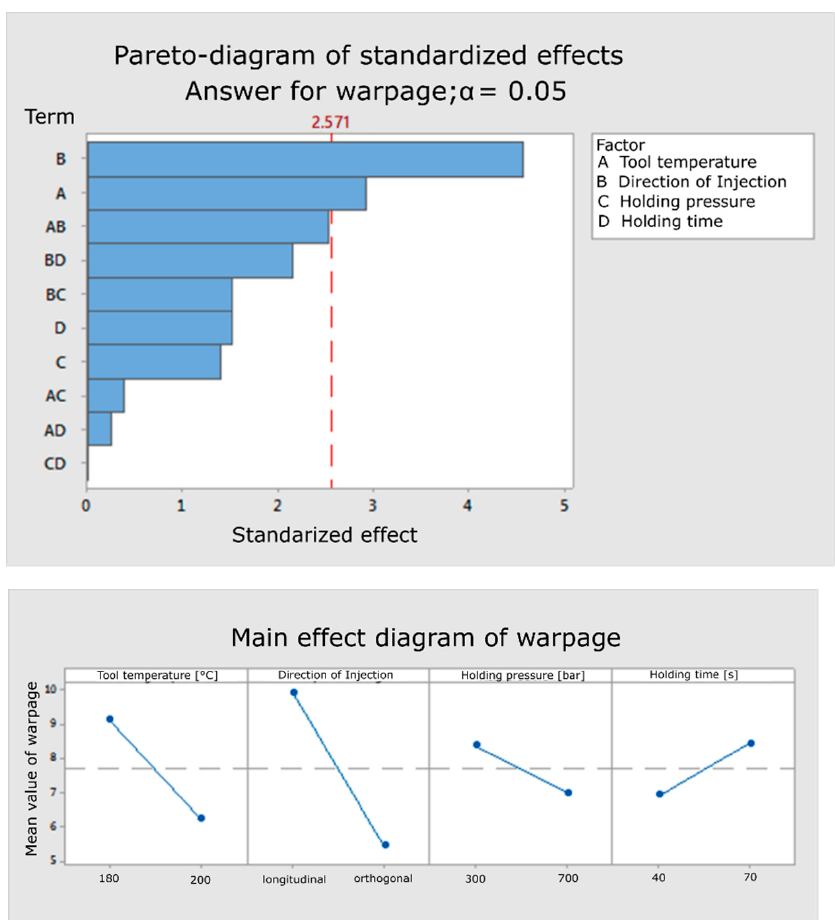
Figure 9. Evaluation of warpage of spherical glass-filled thermoset. ( Top ) Pareto diagram with the threshold for significance. ( Bottom ) main e ff ect